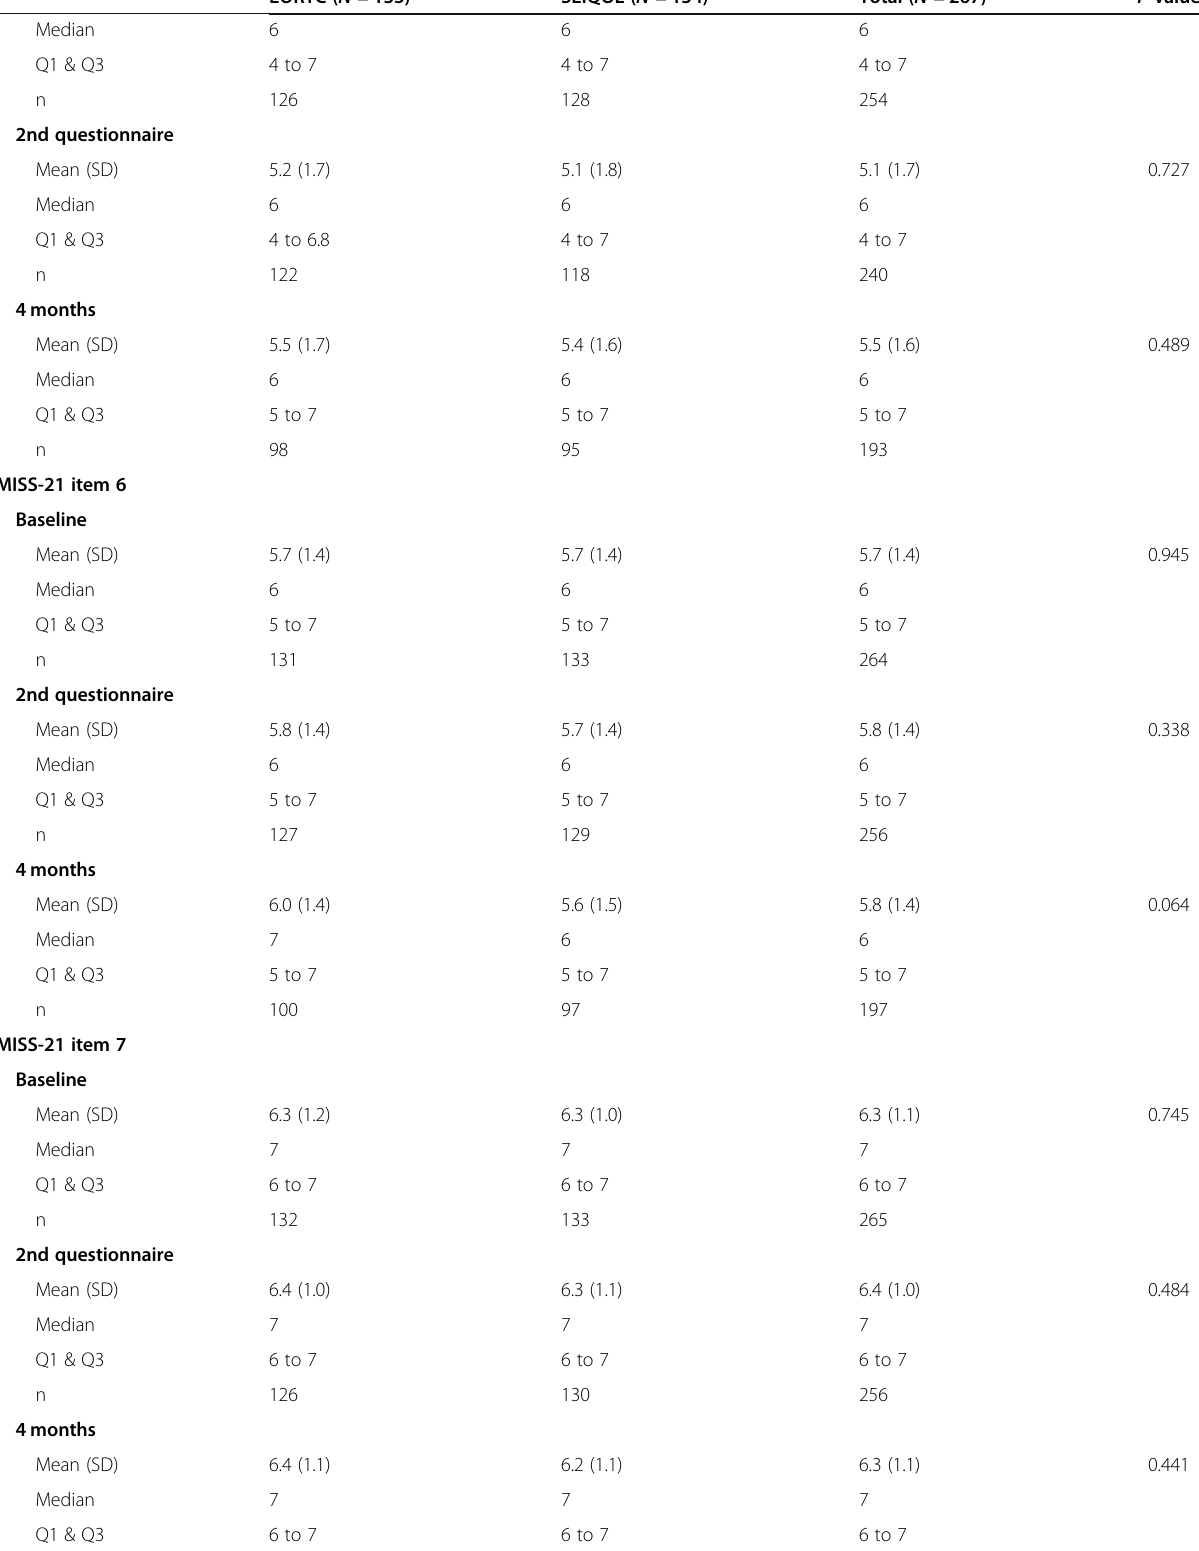
Table 2 Outcomes a over time for analyzed patients